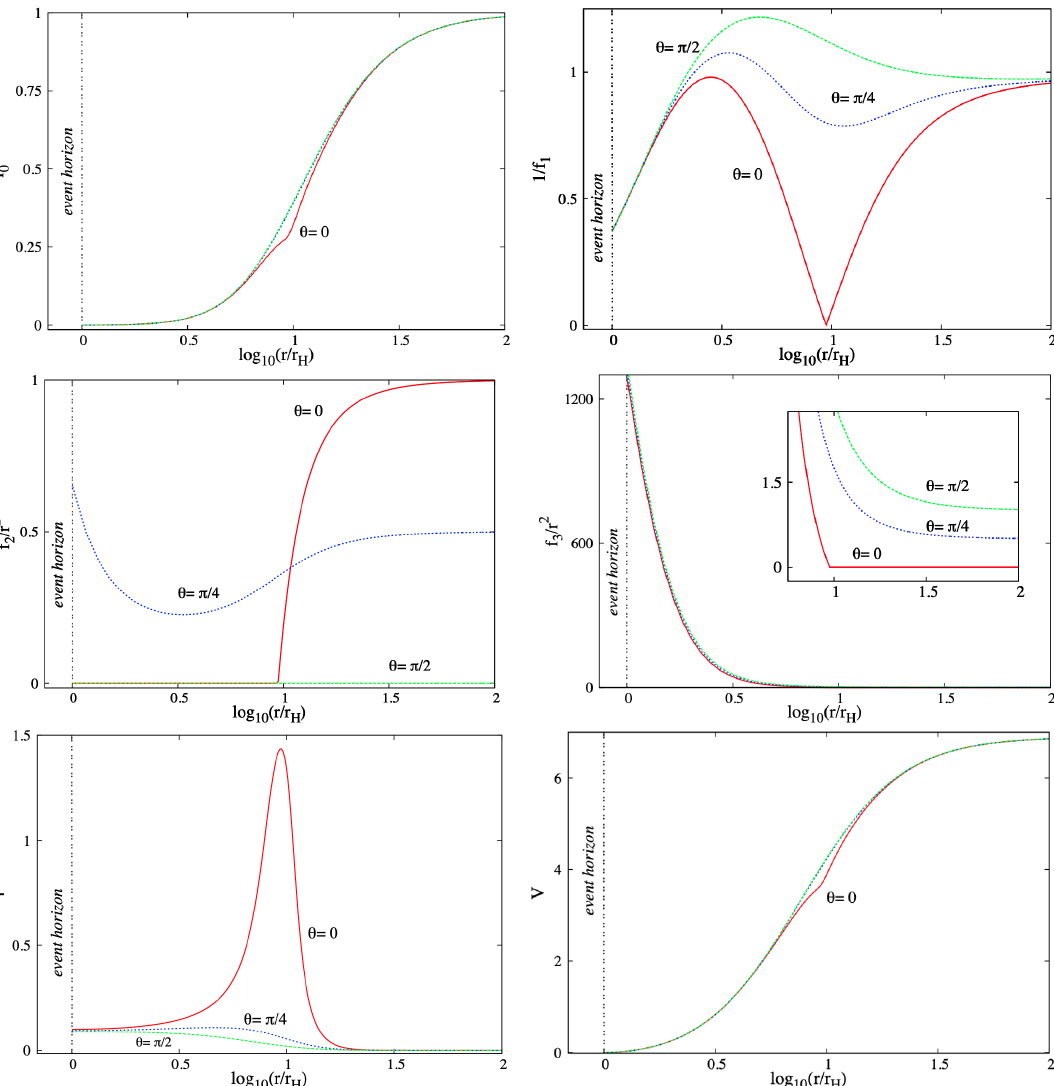
Figure 5 . Profile functions of a typical static BR solution with gauged scalar hair are shown for three values of the angular coordinate θ . The input parameters are r α = 0 . 121 , ν = 0 . 285 , Φ = 6 . 9 , e = 0 . 12